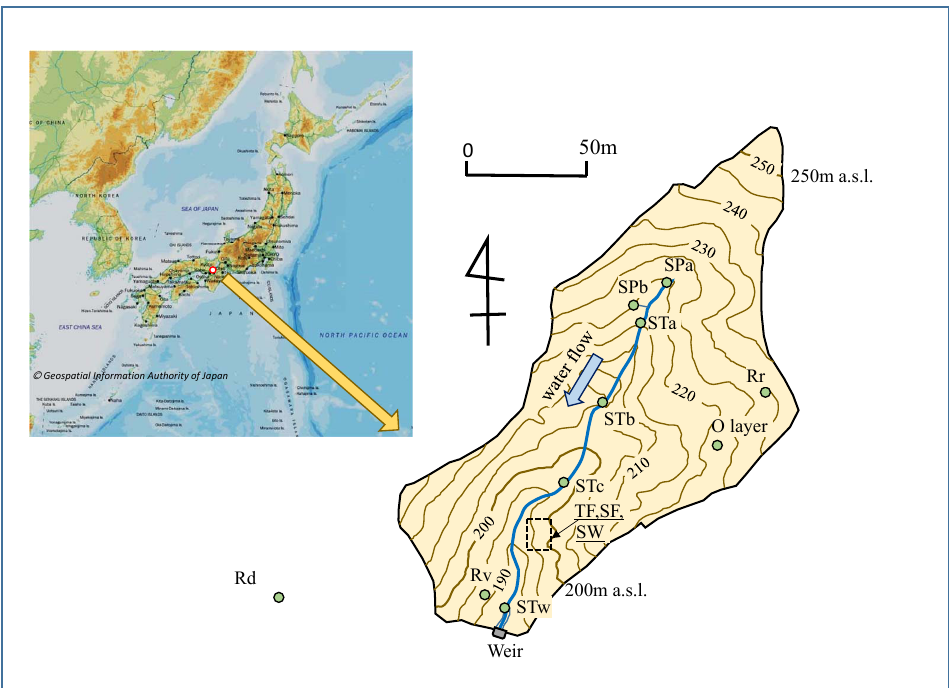
Figure 1. Locations of sampling sites in Yamashiro Experimental Forest (YMS). Rv, Rr, Rd: bulk rain in a closed valley, on a ridge, and at a southwest point of the watershed, respectively ; TF, SF: throughfall and stemflow, respectively ; O layer: O layer leachate ; SW: soil-percolating waters at depth of 10 cm, 30 cm, and 70 cm (So10, So30, and So70) ; SPa, SPb: seepage water at each point; STa, STb, STc: stream water at each point; STw: stream water at a closed point of the weir. The square area with dotted line indicates sampling points of TF, SF, and